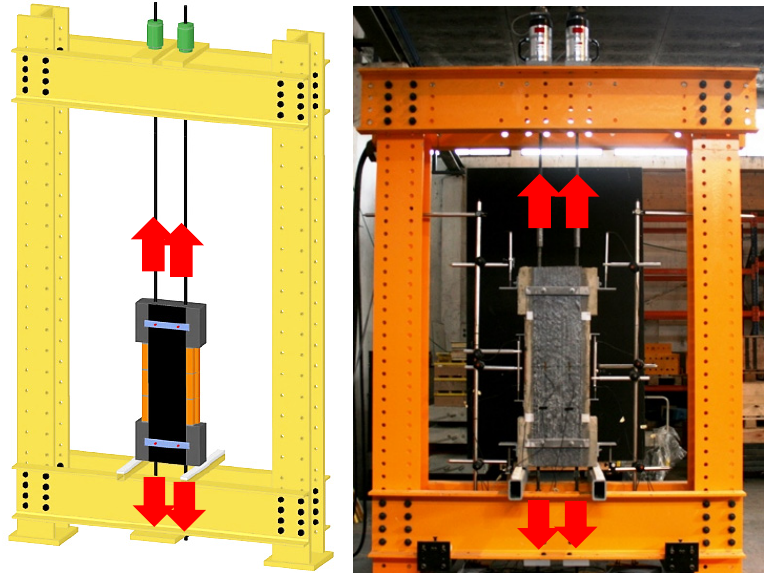
Figure 7. Set-up for static tensile load tests on mechanical anchorage (here: Series